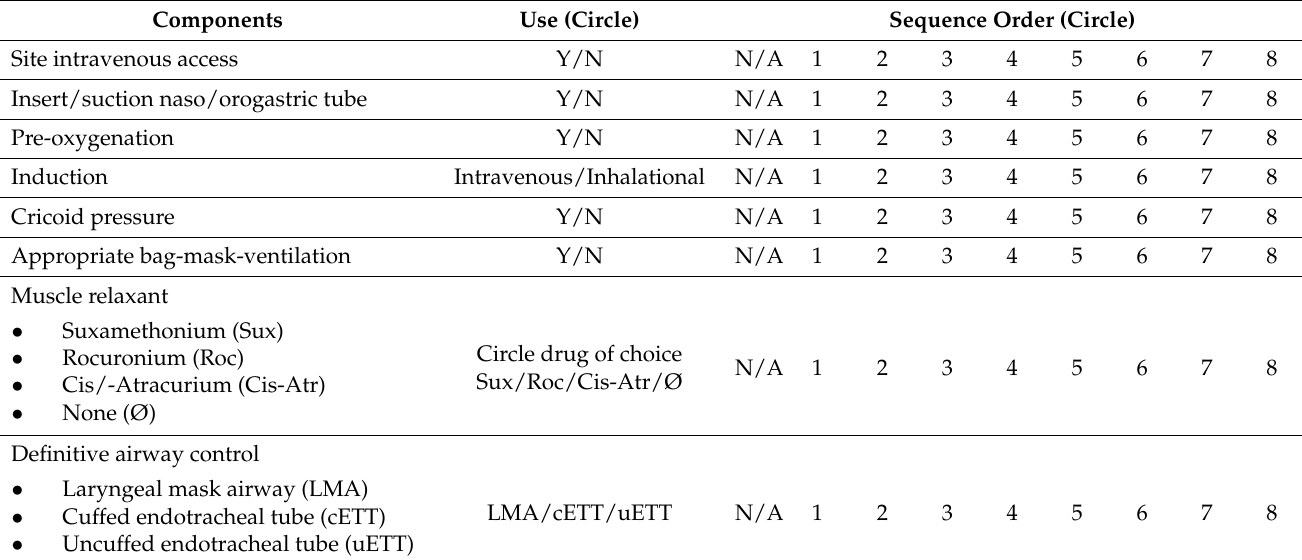
Table 1. Anaesthesia technique details for